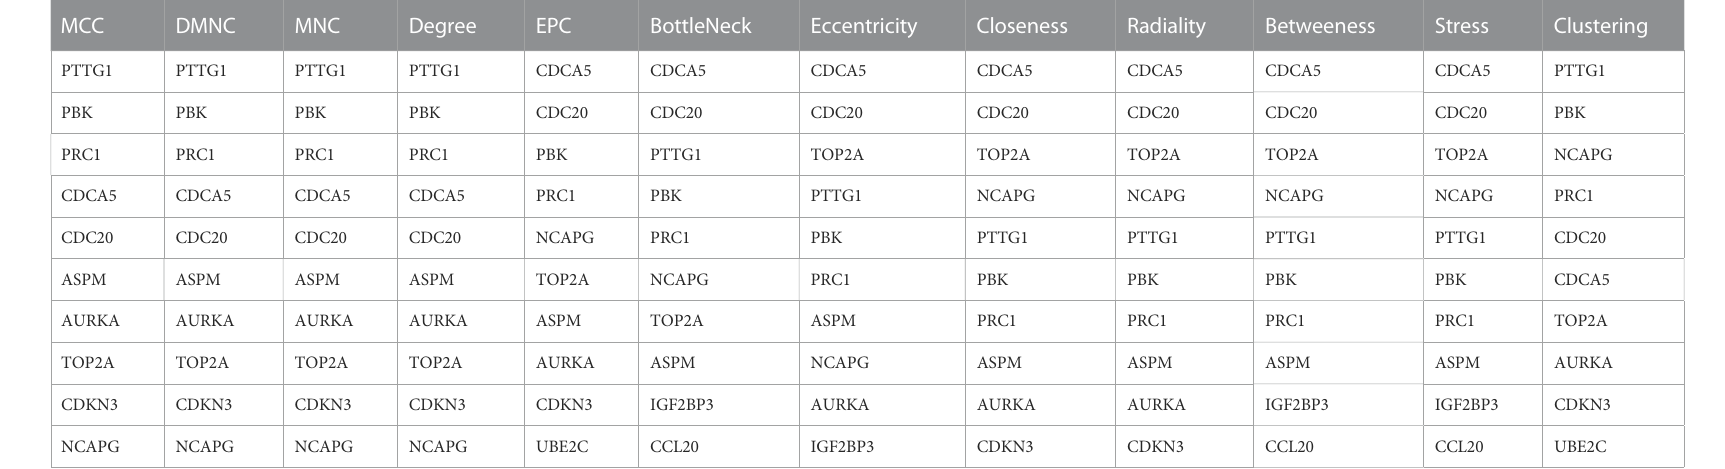
TABLE 1 Top 10 up-regulated DEGs by using 12 topological analysis methods of